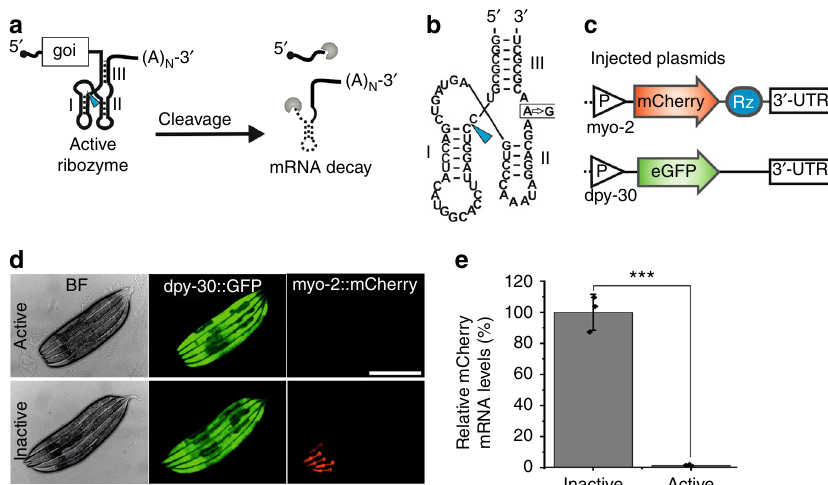
Fig. 1 Impact of self-cleaving ribozymes on gene expression in C. elegans . a Schematic showing how ribozymes in the 3 ’ -UTR affect mRNA stability. Blue arrow indicates self-cleavage site. (A) N indicates poly-A tail. goi, gene of interest. b Sequence and secondary structure of type 3 hammerhead ribozyme with characteristic stems I – III. Blue arrow indicates cleavage site. Box indicates inactivating A-to-G mutation. c Schematic showing constructs injected into worms. Active and inactive ribozyme variants were inserted into the myo-2p::mCherry construct. P promoter. Rz ribozyme. d Microscope images of young adult worms injected with plasmids shown in c . BF, bright fi eld. Scale bar, 300 µ m. e RT-qPCR analysis showing the relative mCherry mRNA levels in young adult animals as shown in d . GFP was used as a reference gene. Error bars, s.d. *** p < 0.001 (two-tailed t -test); n = 3. Source data are provided as a